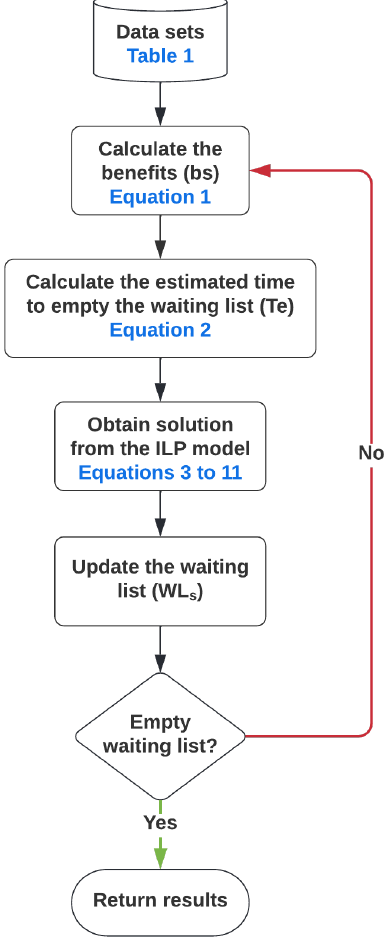
Figure 2. Operating room optimal scheduling